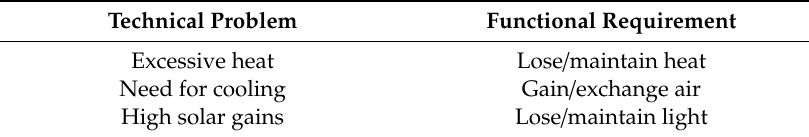
Table 4. Defining technical problems as functional